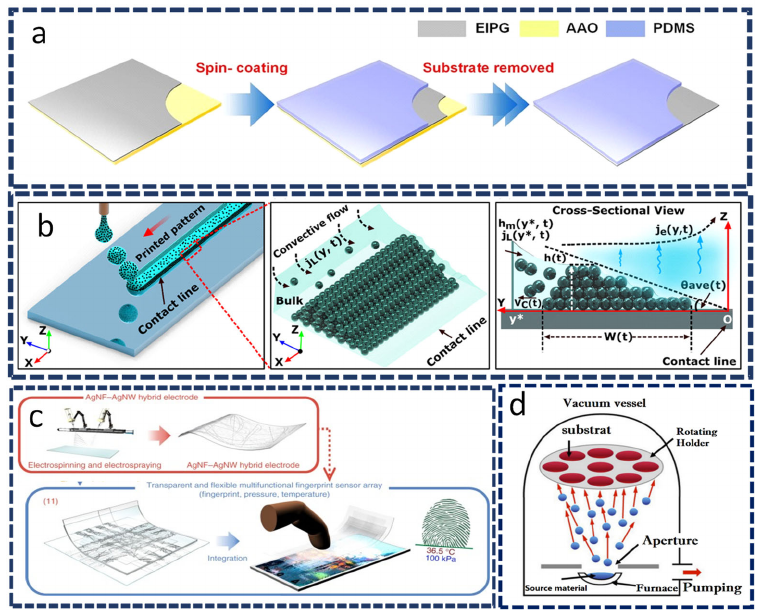
Figure 5. Schematics: ( a ) The flexible electrode is deposited using spin coating with electron ‐ induced perpendicular graphene. Reproduced with permission from Springer Nature (2020) [8]. ( b ) The inkjet ‐ printing controllable process for evaporation ‐ driven convective particle self ‐ assembly at the contact line. Reproduced with permission from Wiley ‐ VCH. (2020) [86]. ( c ) The electrospinning and electrospraying processes of a silver nanofiber (AgNF)–silver nanowire (AgNW) hybrid electrode. Reproduced with permission from Springer Nature (2018) [65]. ( d ) Thermal evaporation coating. Reproduced with permission from MDPI (2019) [91].